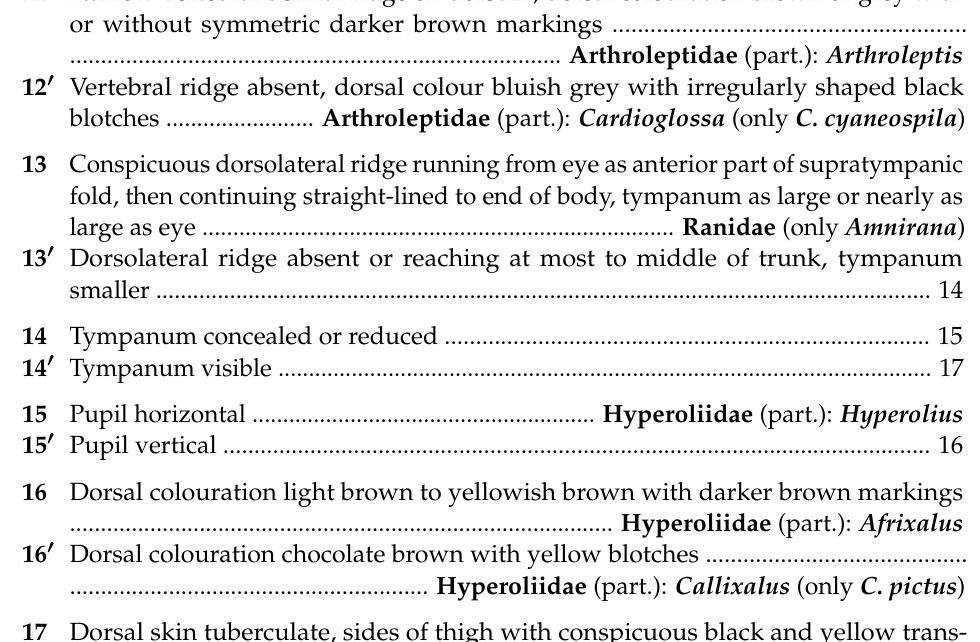
12 Narrow vertebral dermal ridge on dorsum, dorsal colouration brown or grey with